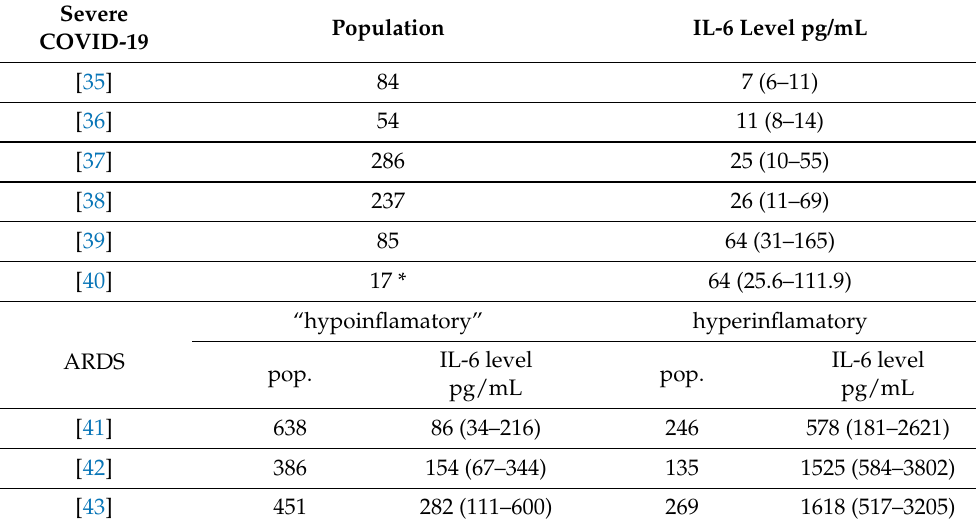
Table 1. Plasma level of Interleukin-6 (IL-6) reported in severe cases of COVID-19, as well as in “hypo” and hyperinflammatory processes in acute respiratory distress syndrome (ARDS). * Critically ill